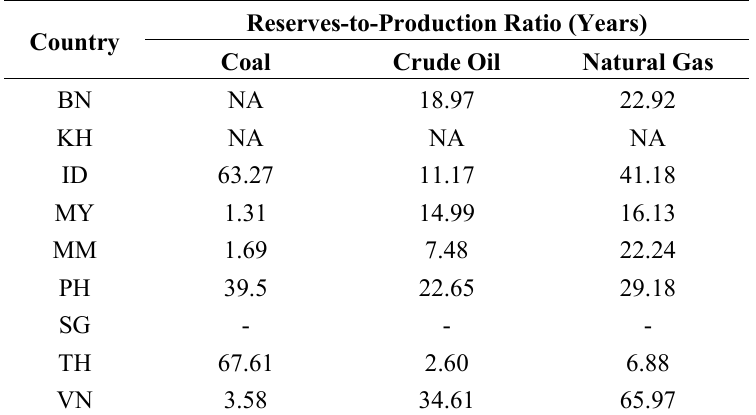
Table 3. Reserves-to-production